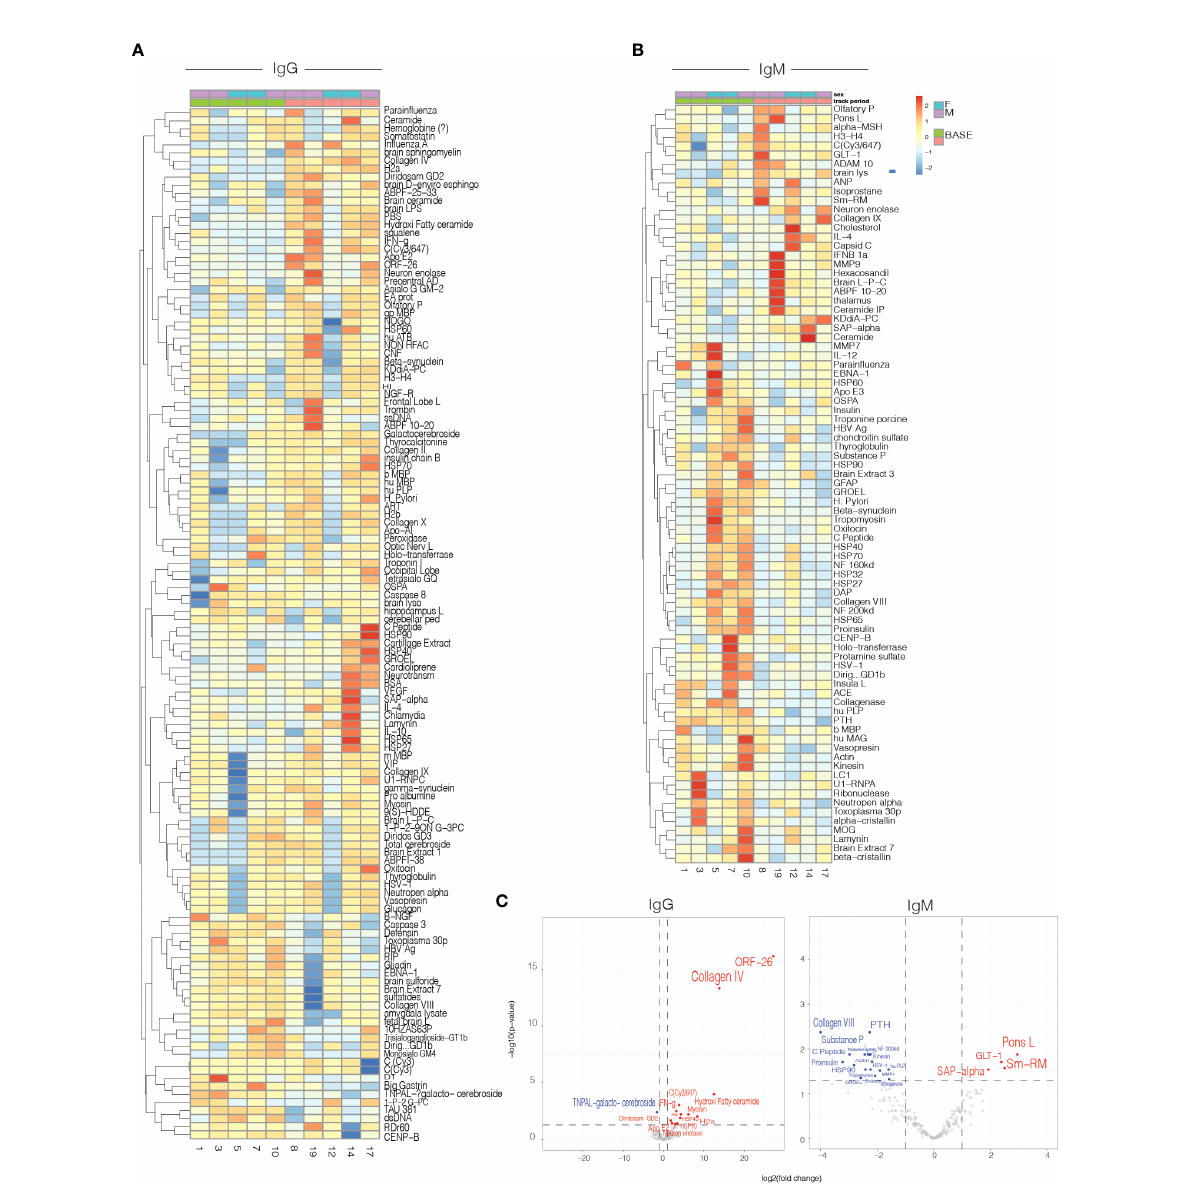
FIGURE 4 Serum IgG and IgM antibody reactivity in patients treated with 50ug. Heatmap representing the mean delta change from Timepoint 1(baseline) to Timepoint 2 (day 7) for: IgG (A) and IgM (B) antibody reactivity in serum samples from patients. (C) Volcano plot representing differential IgG and IgM antibody reactivity. Cut-off criteria was de fi ned as p-value < 0.05 and log2 fold change > 1 or < −